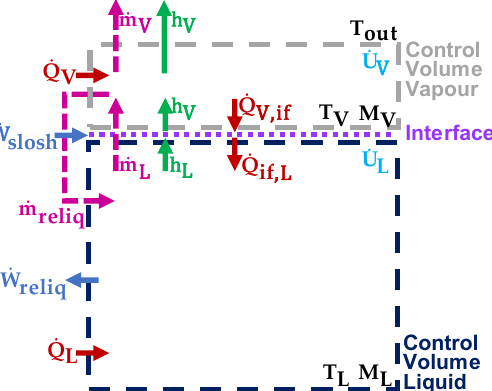
Figure 2. Control volume for liquid and vapour phases of cryogenic fuel in an unsealed container, and control surface for the liquid-vapour interface. The cryogenic tank is assumed to operate with reliquefaction. Thermodynamic properties are shown, which include: the temperature of liquid ( T L ), vapour ( T V ) and external environment ( T out ); the mass of liquid ( M L ) and vapour ( M V ); the heat transfer rate into the liquid ( Q ̇ L ), into the vapour ( Q V ) and across the liquid-vapour interface ( Q if ); the rate of change of the internal energy of the liquid ( U ̇ L ) and vapour ( U ̇ V ); the specific enthalpy flow out of the liquid ( h L ) and through the vapour ( h V ); the mass flow rate out of the liquid ( m ̇ L ) and vapour ( m ̇ V ); the rate of fuel reliquefaction ( m ̇ reliq ); the kinetic energy transfer rate due to sloshing ( W ̇ slosh ); and enthalpy extraction rate during the reliquefaction process ( W ̇ reliq ).